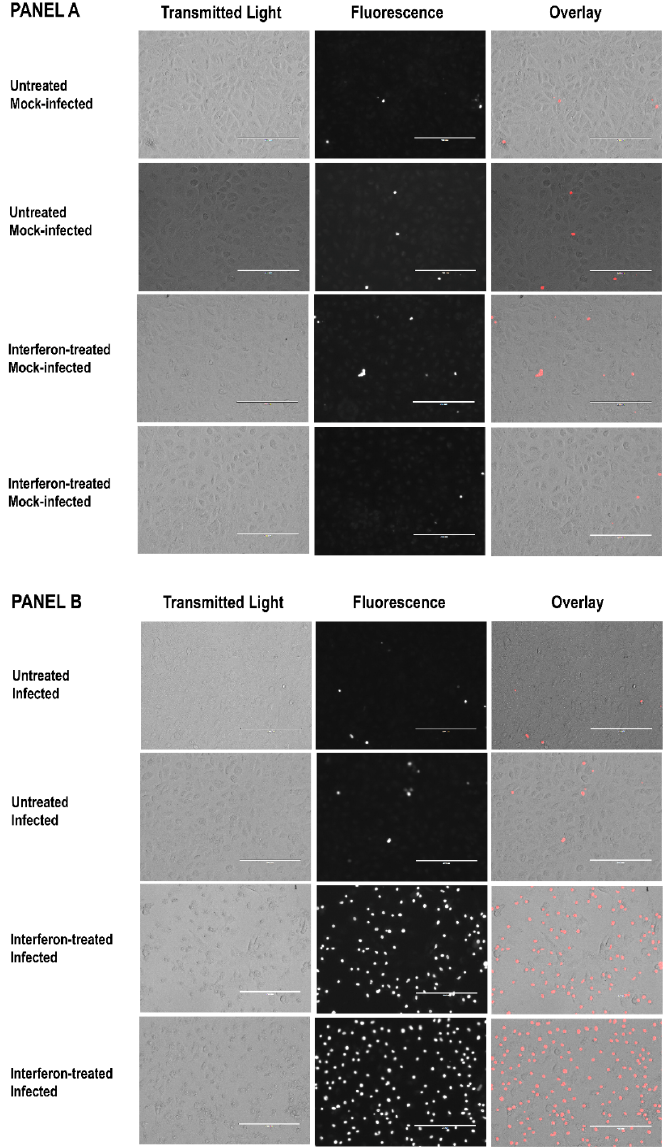
Figure 2. Results of ethidium bromide staining of untreated and IFN- γ -pretreated endothelial cells 3 to 6 h after the start of the mock infection (Panel A ) or after addition of R. prowazekii (Panel B ). The micrographs show duplicate cultures from a representative experiment. Figure S1 shows all images from the experiment, and indicates which images are shown here. Each bar represents 200 µ m. To eliminate concern about image manipulation, all transmitted light images were captured under identical conditions, and all fluorescence images were captured under identical conditions as well. All transmitted light micrographs and all overlays were then adjusted for exposure and contrast using identical settings in Adobe Photoshop CC 2018 ®